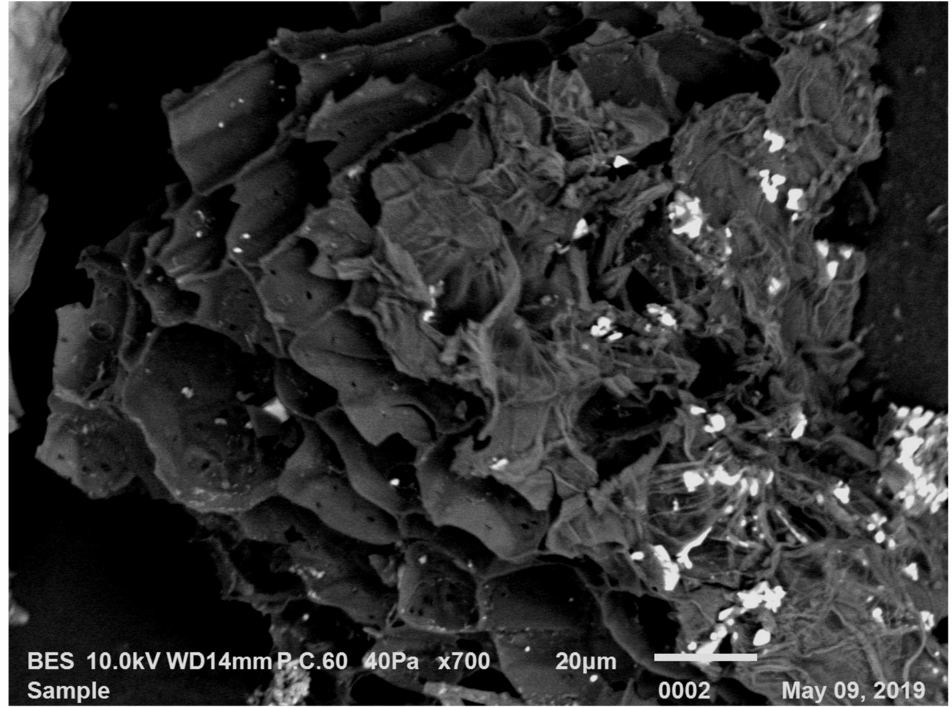
Figure 1. Rice husk biochar surface at 700 × magnification under